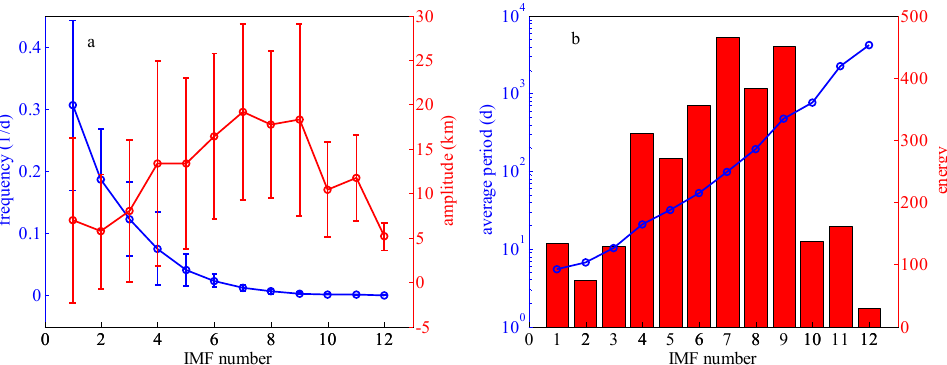
Figure 5. ( a ) Mean frequency (red circles) and amplitude (blue circles) for all IMFs shown in Figure 4. Error bars are the standard deviation. ( b ) Mean period of the IMFs (blue circles) and the signal energy (red histograms).